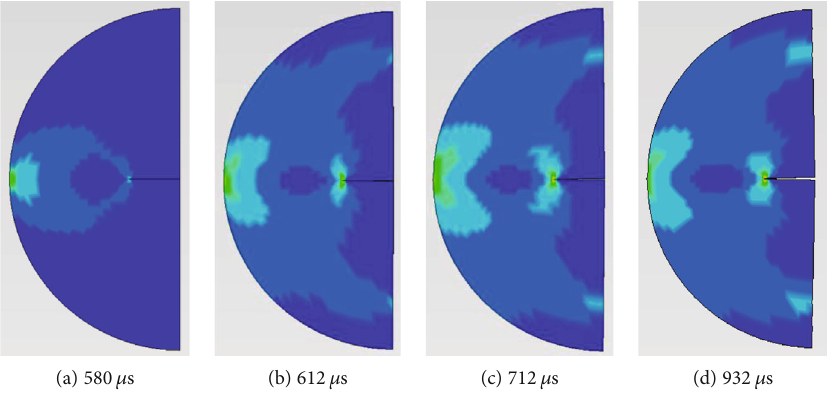
Figure 11: Stress distribution in NSCBD specimens at di ff erent times.